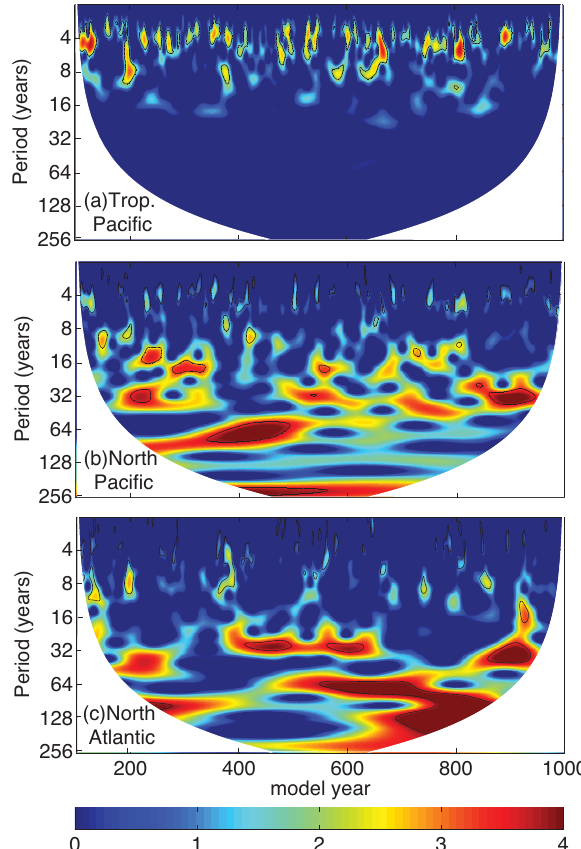
] in the (a) tropical Pacific, (b) 3